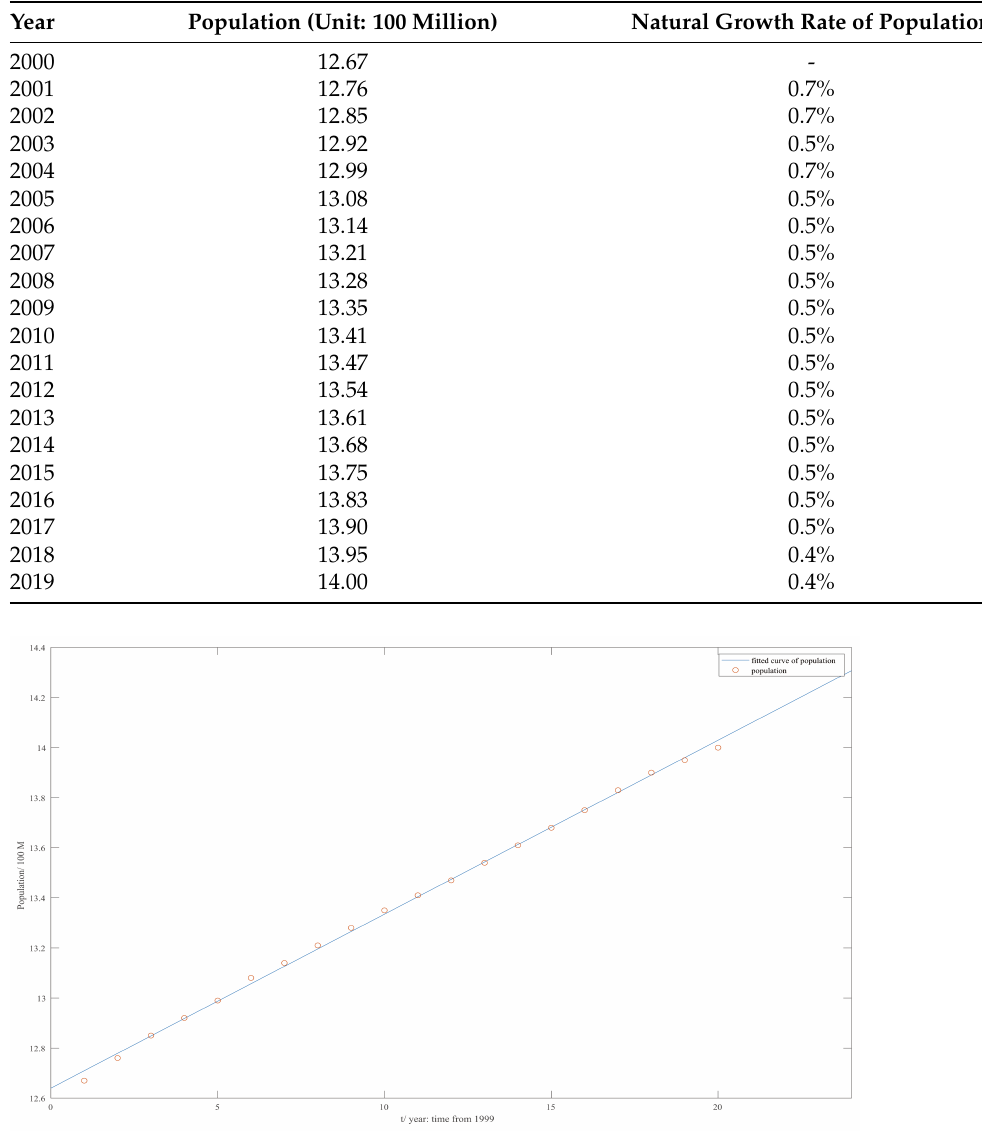
Figure 2. Population and fitting curve for China from 2000 to